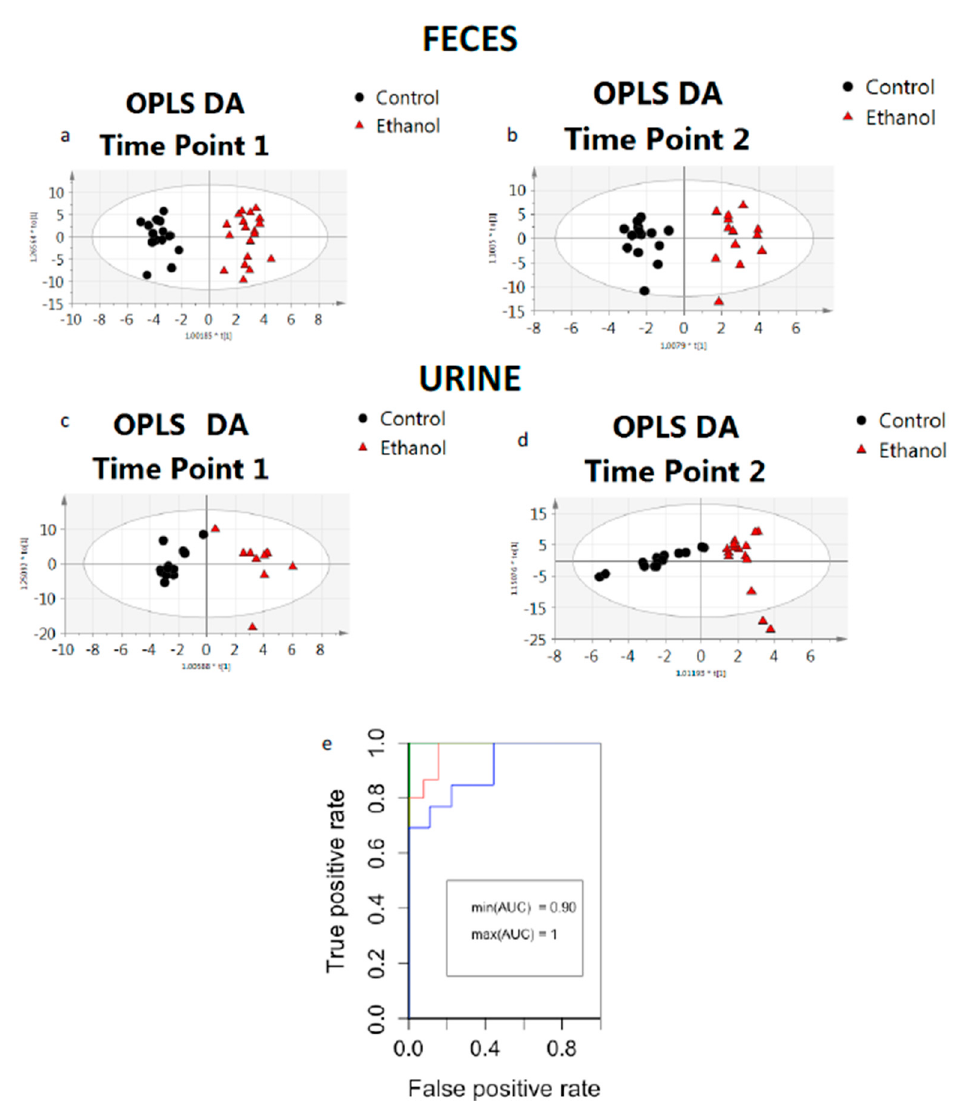
Figure 2. OPLS DA score plots constructed based on metabolic profiles acquired from fecal samples at ( a ) sampling time point 1 and ( b ) time point 2 and the corresponding score plots constructed based on metabolic profiles of urine samples at ( c ) sampling time point 1 and ( d ) time point 2, (x-axis: first principal component t[1]; y-axis: the first component to[1]), while in ( e ) overlay ROC curves for the models are shown. Table 1. Data statistics from all constructed OPLS DA models.